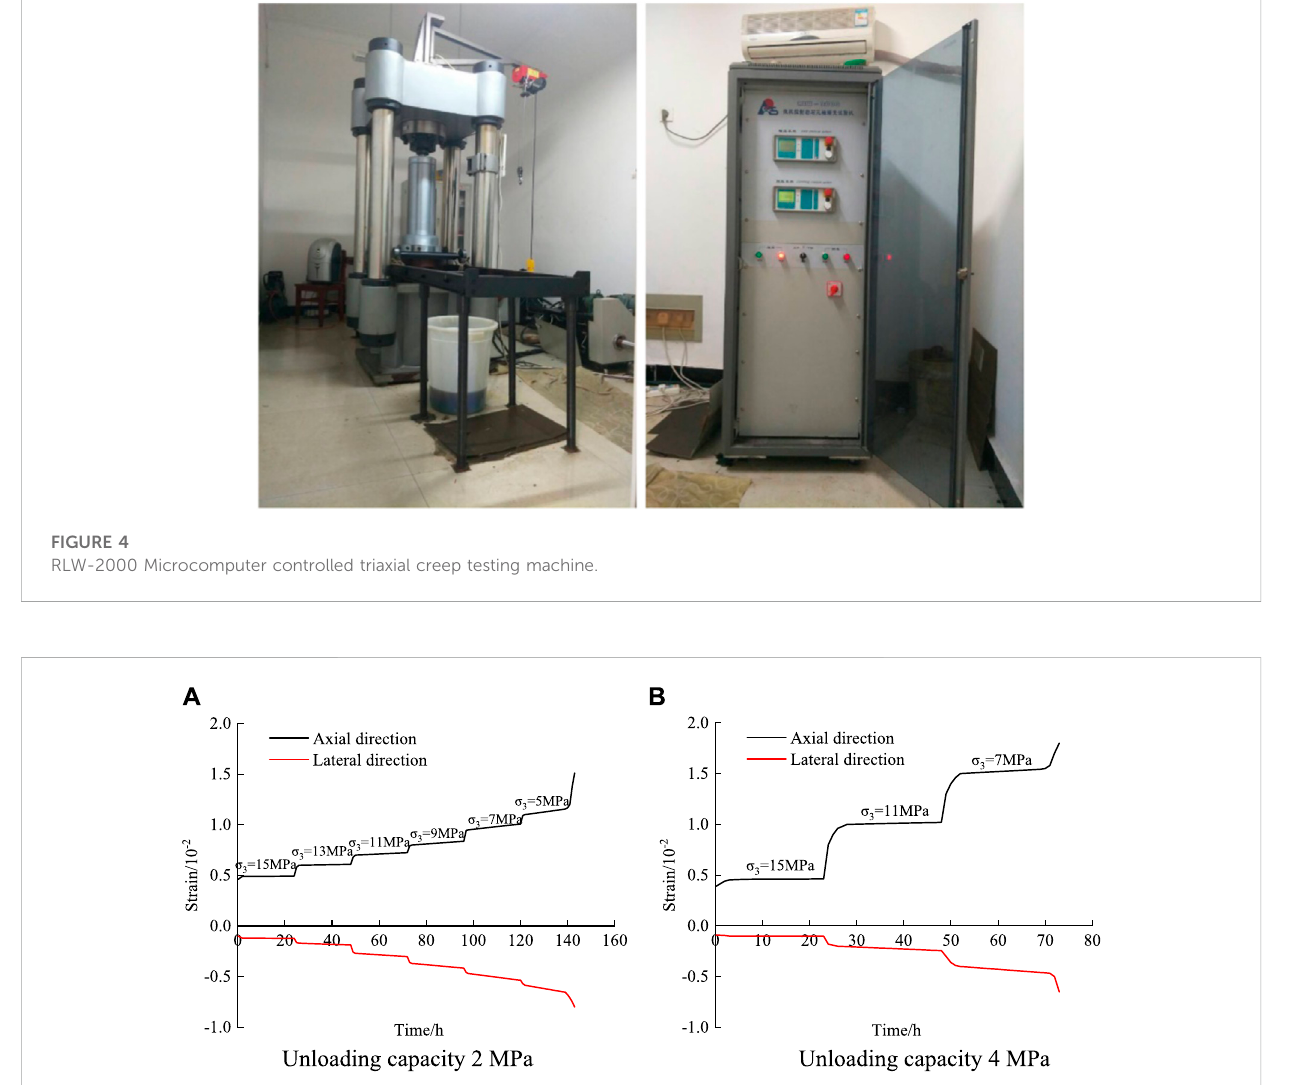
FIGURE 5 Triaxial unloading creep test curves of Flint limestone under different unloading amounts. (A) Unloading capacity 2 MPa (B) Unloading capacity 4